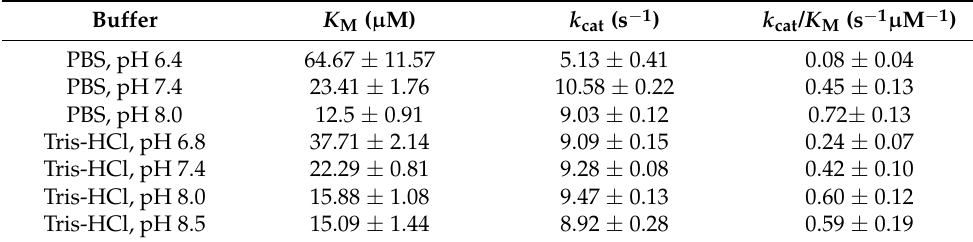
Table 3. The effect of pH on the enzymatic activity of